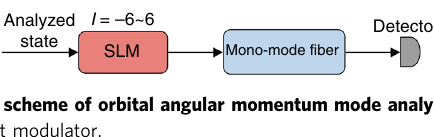
computer-generated hologram with a topological charge − ℓ on the SLM. Due to the fact that only the Gaussian mode can be coupled into the mono-mode fi ber, the output beam power of the mono-mode fi ber almost only contains the power of the corresponding teleported OAM mode carrying topological charge of ℓ under high coupling ef fi ciency of the fi ber. We load the computer-generated hologram with a topological charge ranging from − 6 to 6 on the SLM. In this way, we can obtain the proportion of the OAM mode with a topological charge from − 6 to 6.